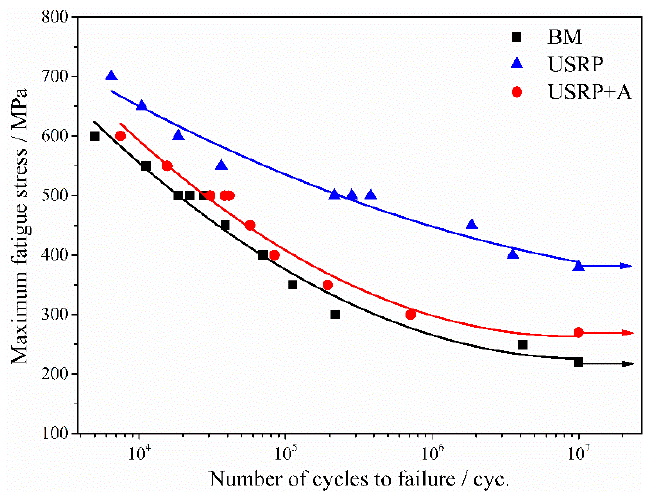
Figure 8. Stress/life (S-N) curves for BM, USRP + A and USRP samples.